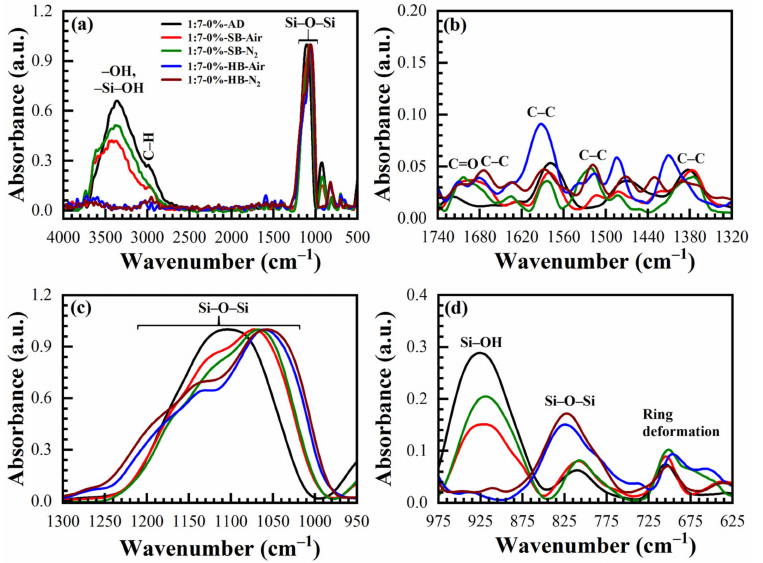
Figure 5. FTIR spectra of benzene-bridged (135TTEB:13BTEB = 1:7 material) organosilicate films without porogen loading, where ( a ) full FTIR spectra; and ( b – d ) are the parts of the full FTIR spectra. The films are as-deposited (AD), soft baked (SB) at 150 ◦ C in air (SB-Air) and N 2 (SB-N 2 ) for 30 min, hard baked (HB) at 400 ◦ C in air for 30 min (HB-Air) and in N 2 (HB-N 2 ) for 60